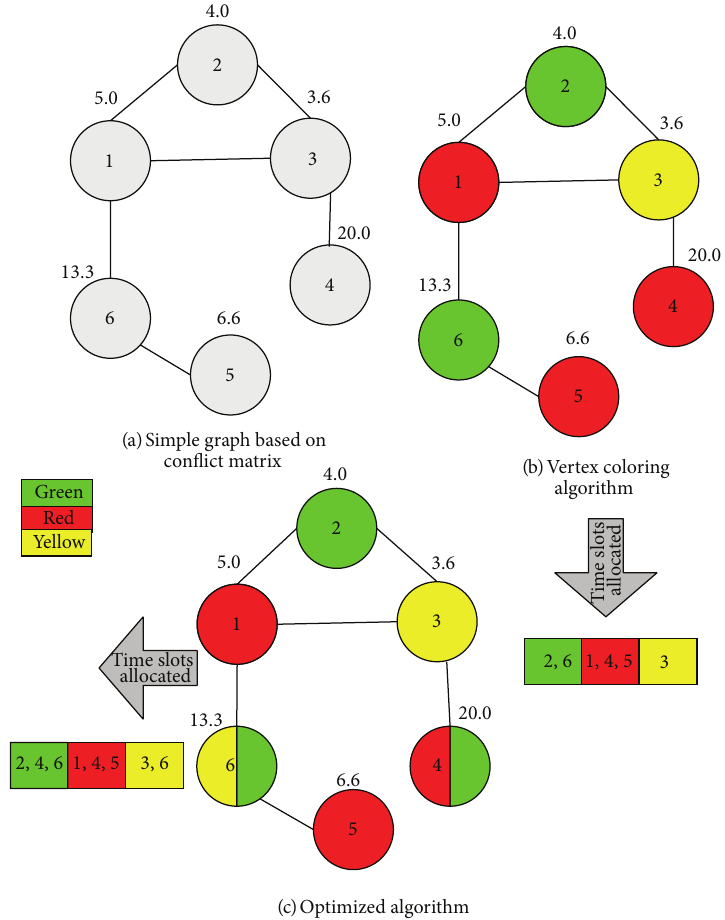
Figure 7: Conflict graph representation of VC and